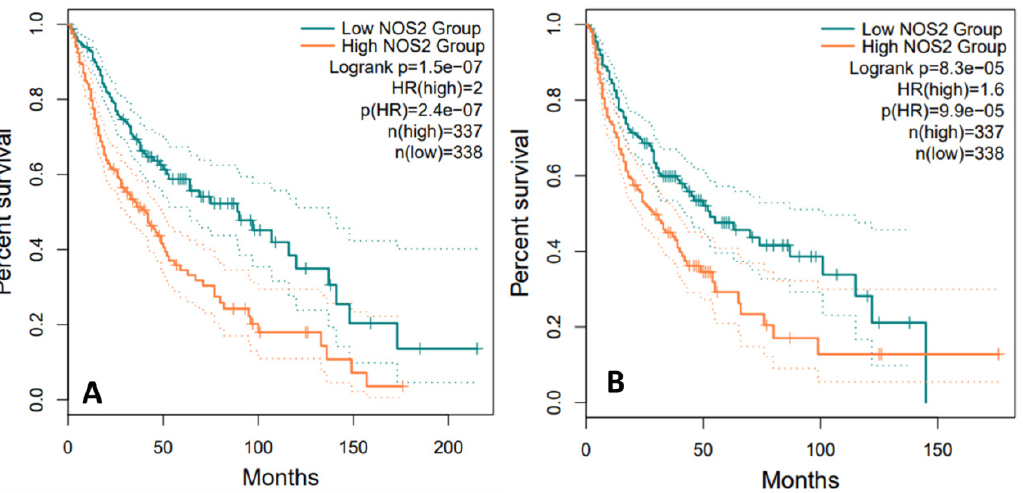
Figure 6: Survival curve of iNOS/NOS2 expression and prognosis in patients with glioma (A: Overall survival of iNOS/NOS2 low and high expression groups; B: Disease-free survival of iNOS/NOS2 low and high expression